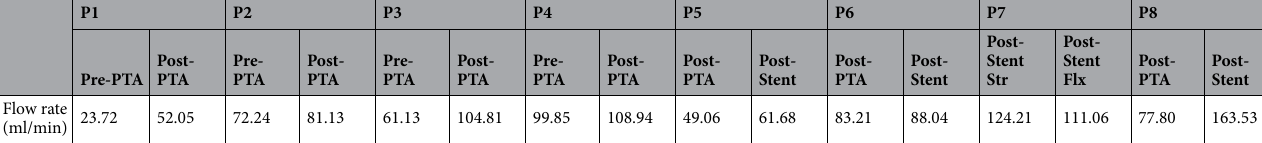
Table 5. The time-averaged flow rate values computed at the inlet for each